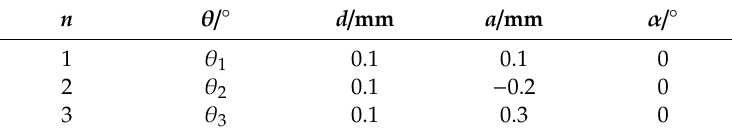
Table 7. The DH parameters of the robot with three parallel